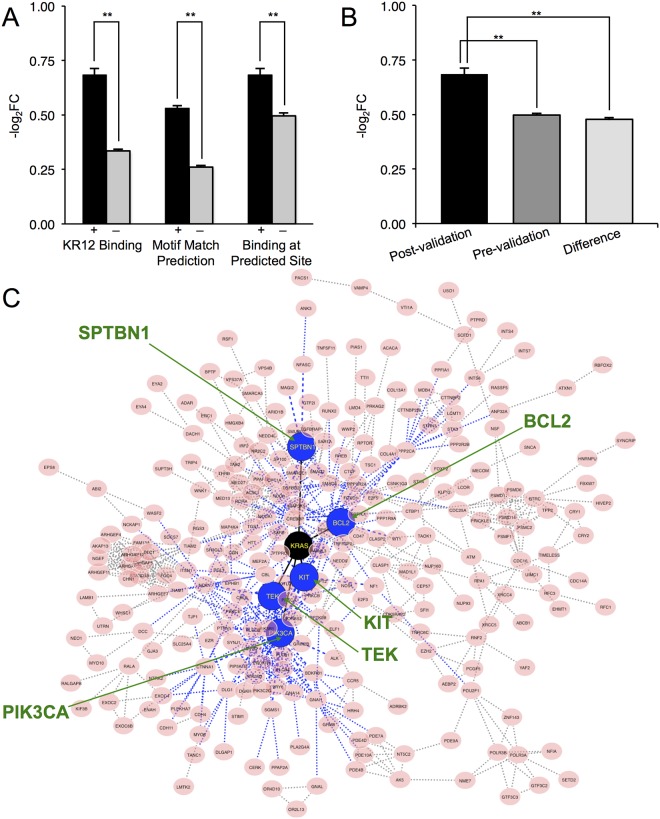
Genome-wide effect of KR12 binding and implications of mutant codon 12 KRAS as a driver gene.(A) Mean expressions (vertical axis,–log2FC) from RNA microarray analysis. Left: genome-wide KR12 binding (KR12-bound ‘+’, black; otherwise ‘–’, gray); middle: genes with computationally predetermined motif matches (‘+’) and those without (‘–’); right: expressions of genes with identified sites (‘+’) compared to genes with motif matches but no binding (‘–’) as determined by the workflow. **, p < .01 from two-sample Welch’s t-test; error bars indicate ±1 SEM. (B) Mean expressions (–log2FC) of identified KR12-bound genes (“Post-validation”) compared to candidate genes following sliding-window determination (“Pre-validation”); “Difference” indicates pre-validation candidates not found in the Post-validation group. Error bars, ±1 SEM; **, p < .01 from two-sample Welch’s t-test. (C) Interaction network of down-regulated KR12-bound genes. KRAS (black) and its first neighbors (blue, marked with green arrows) are linked by solid black edges. Blue dashed edges indicate direct interactions with first neighbors of KRAS.